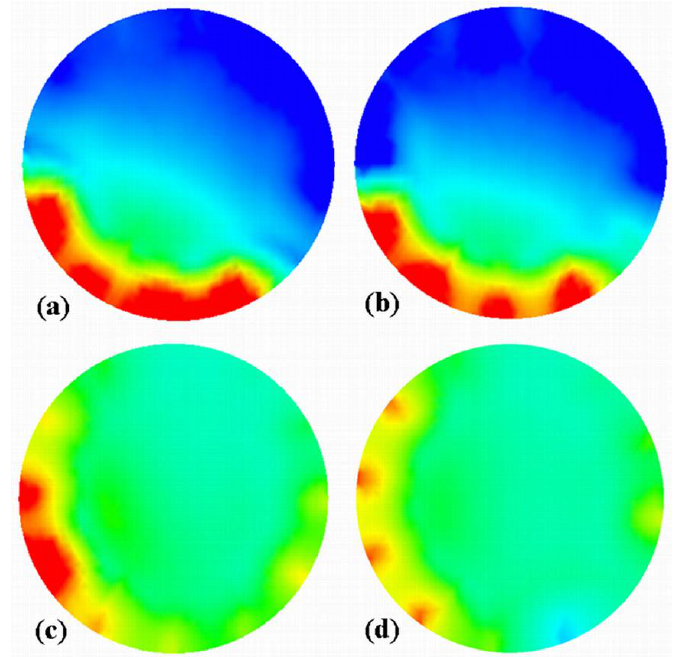
Figure 6. Four images ( a – d ) of the slug #3 reconstructed with LBP from capacitance data measured for individual successive positions of the motor (see that the image ( d ) corresponds to the one used for LBP / no rotation shown in Figure 5). This set was acquired anticlockwise.